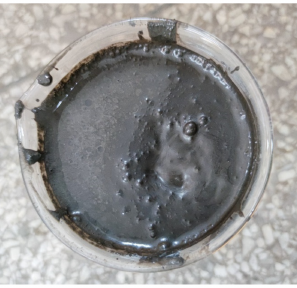
Figure 3. Particle size grading scheme 1: paste with 75% mass fraction.